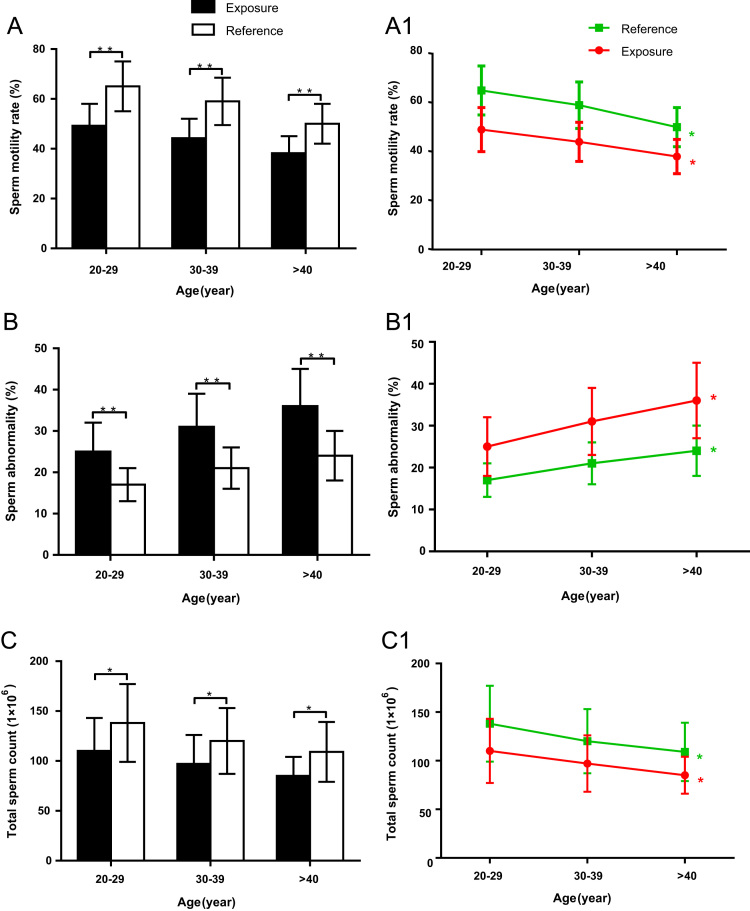
Sperm motility rate, abnormality rate and total sperm counts for different age sub-groups. A-C: Sperm motility rate, abnormality rate and total sperm counts between the group of workers recycling e-wastes and reference group for the sub-groups divided by age. There is significant difference of sperm motility rate, abnormality rate and total sperm counts between the group of workers recycling e-wastes and reference group in the age sub-groups, respectively. A1-C1: Line chart showed the change of sperm motility rate, abnormality rate and total sperm counts along with age. There is significant difference of sperm motility rate, abnormality rate and total sperm counts among the age sub-groups in exposure or reference group respectively. **: P < 0.01, *: P < 0.05. Two way ANOVA was also used to test the interactions between age and sperm motility rate, abnormality rate and total sperm counts, respectively. (sperm motility rate: F = 3.24, P = 0.07; abnormality rate: F = 3.13, P = 0.08; total counts: F = 2.89, P = 0.12).